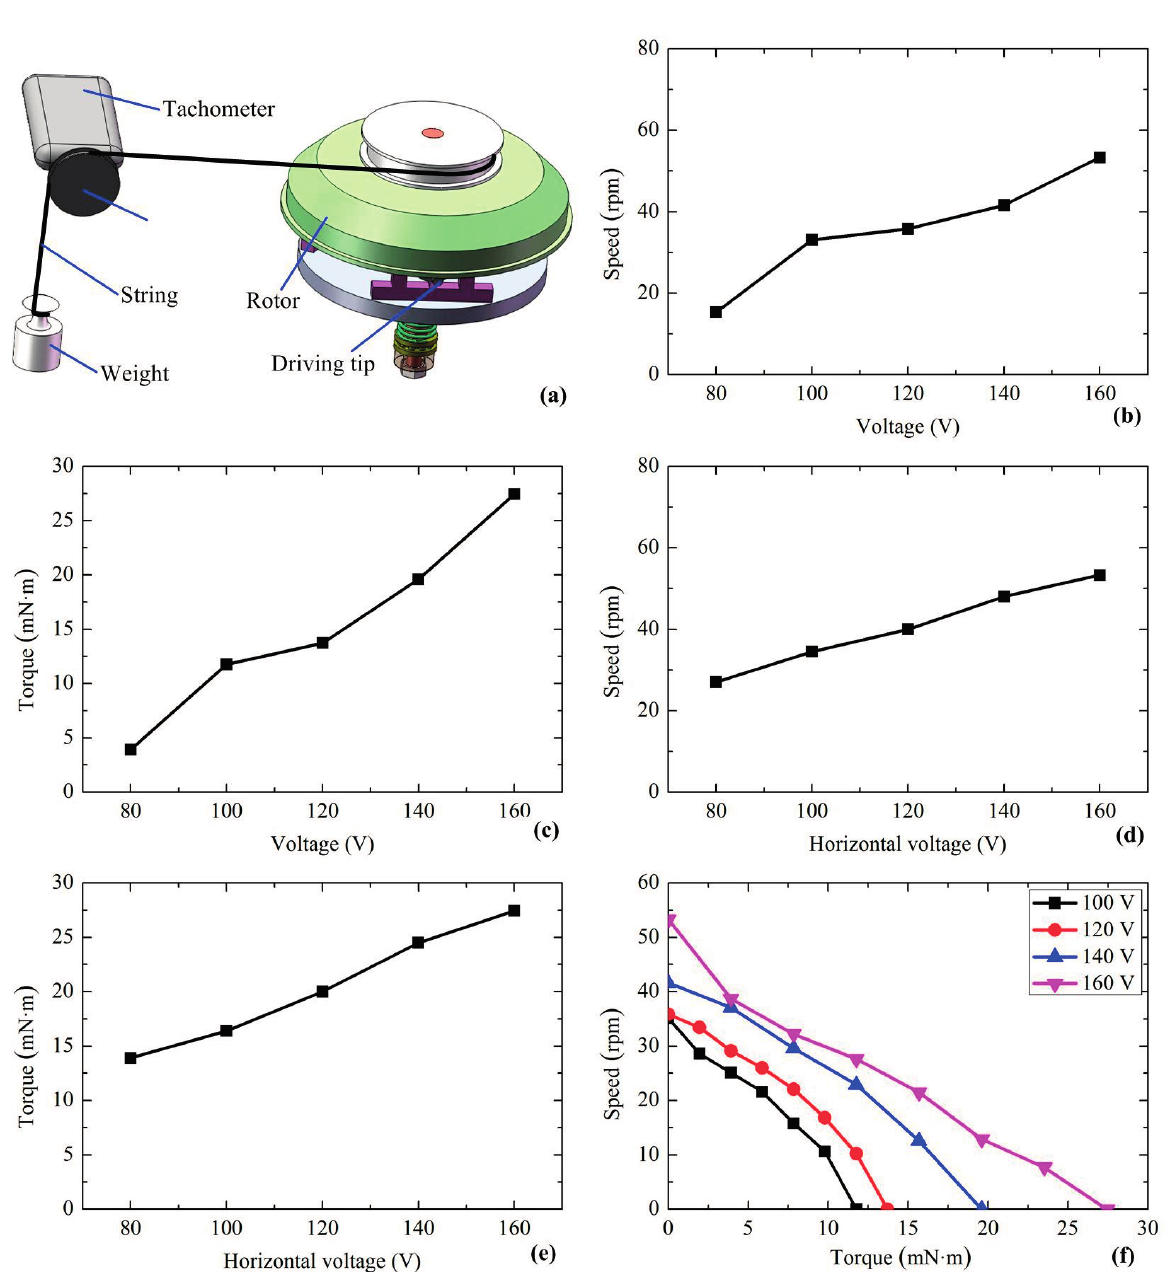
Figure 9. The mechanical output performance of the prototype: ( a ) the experiment set-up; ( b ) plot of the no-load speed versus the sine and cosine voltages; ( c ) plot of the maximum torque versus the sine and cosine voltages; ( d ) plot of the no-load speed versus the sine voltage under cosine voltage of 160 V p-p ; ( e ) plot of the maximum torque versus the sine voltage under cosine voltage of 160 V p-p ; ( f ) plot of the speed versus the torque under different